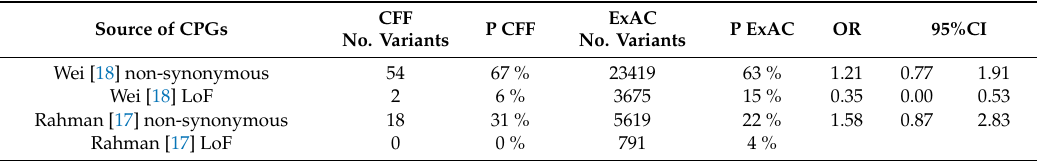
Table 3. Comparison of the probability of carrying potentially pathogenic non-synonymous and loss of function (LoF) variants within cancer predisposition genes (CPGs) in cancer-free families (pCFF) and in the ExAC population (pExAC). Pathogenicity was evaluated using the criteria of our in-house developed Familial Cancer Variant Prioritization Pipeline version 2